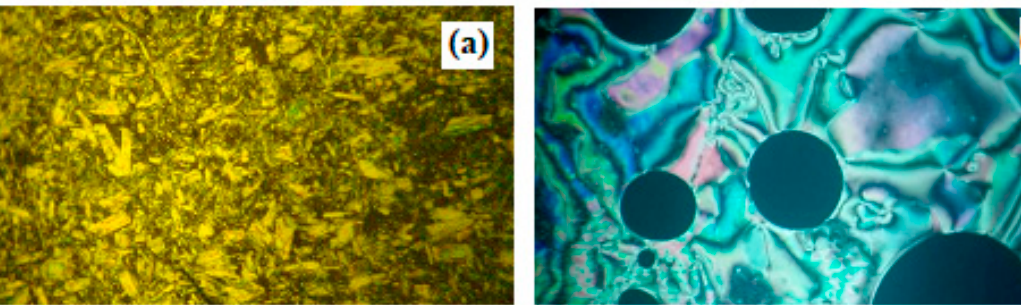
Figure 2. Effect of the alkoxy-chain length ( n ) of the azopyridine derivatives ( III m ) on mesophase behavior of the 1:1 supramolecular hydrogen-bonded complexes ( a ) m = 8; ( b ) m = 16 .